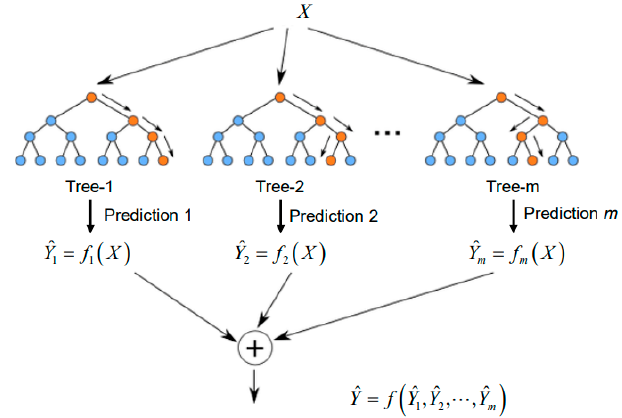
Figure 3. Illustration of the random forest algorithm [23].